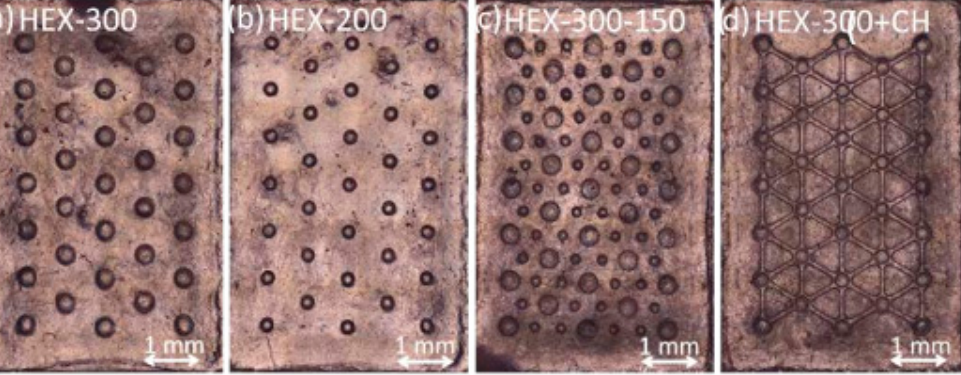
where D represents the measure of a generic feature (diameter, depth, distance) of the mold ( m ) and sample ( s ). The most evident result is that the replication of HDPE samples is better than UHMWPE, as expected and already mentioned, due to the high viscosity of the second material. The percentage errors depend on the type of feature. For HDPE sam- ples, the percentage errors span from 1% to 9% resulting in an average error of 4.3%. In the case of UHMWPE, the percentage errors span from 2% to 31%, resulting in an average error of 11.4%. The higher errors occur on the micro-feature depth with a nominal value